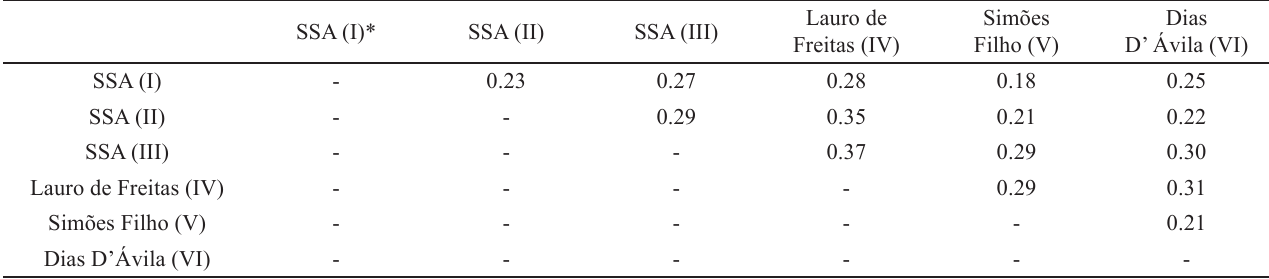
Table 4. Similarity matrix (coefficient of similarity of Jaccard, CS) between meliponaries based on pollen types identified in Melipona scute- llaris honey from highly urbanized and industrialized sites in the Metropolitan Region of Salvador, Bahia,